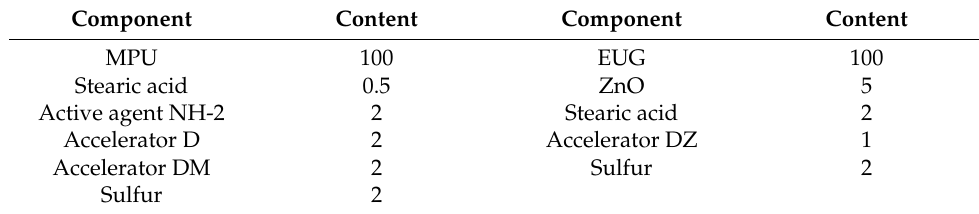
Table 1. Experimental formula of various MPU/EUG composites.